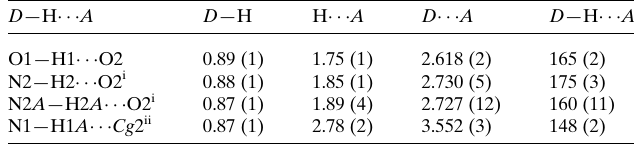
Table 1 Hydrogen-bond geometry (A˚ , (cid:4) ). Cg 2 is the centroid of the C1–C6 ring.